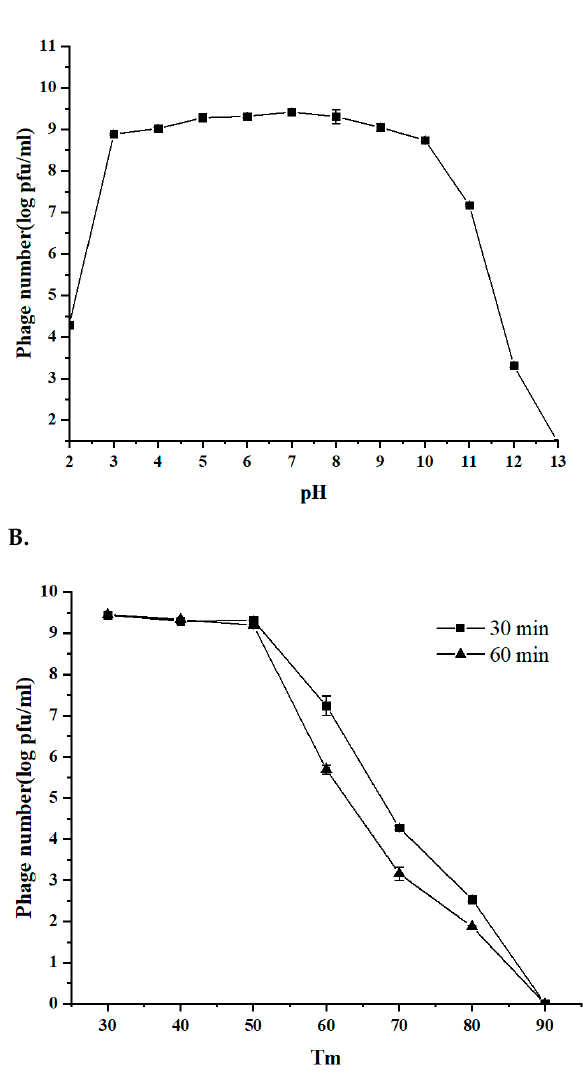
Figure 3. Biological properties of phage BG3P. ( A ) Temperature tolerance in a range from 30 ◦ C to 80 ◦ C. ( B ) pH tolerance after 30 and 60 min of incubation at pH ranging from 2 to 13.Values are the mean of three